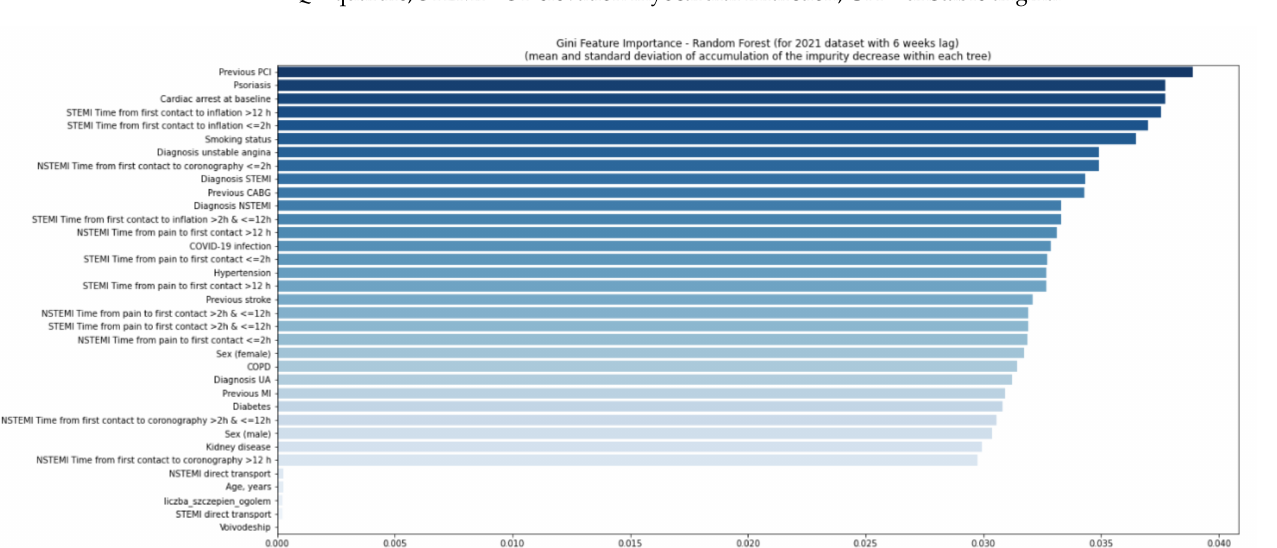
The quality of the model was good (Supplementary Figures S9–S12). In each model, vaccination was the least relevant factor affecting the occurrence of periprocedural